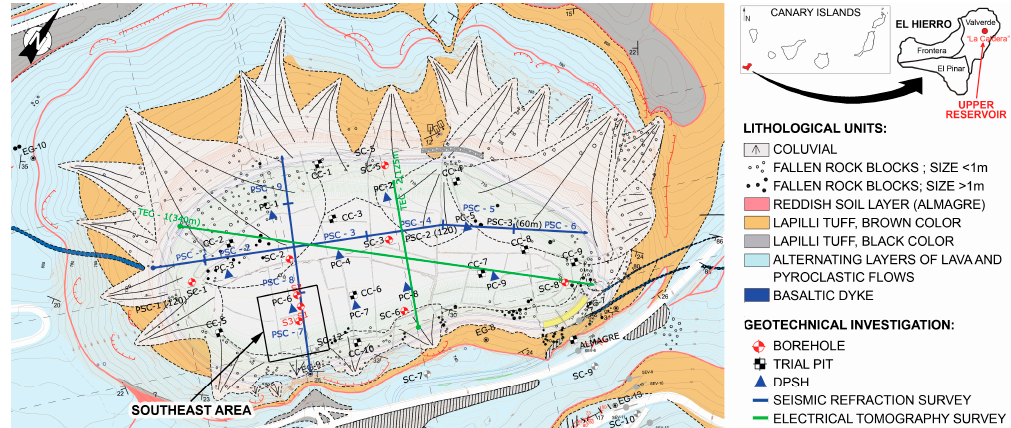
Figure 1. Geological mapping of “La Caldera” place, with the location of site